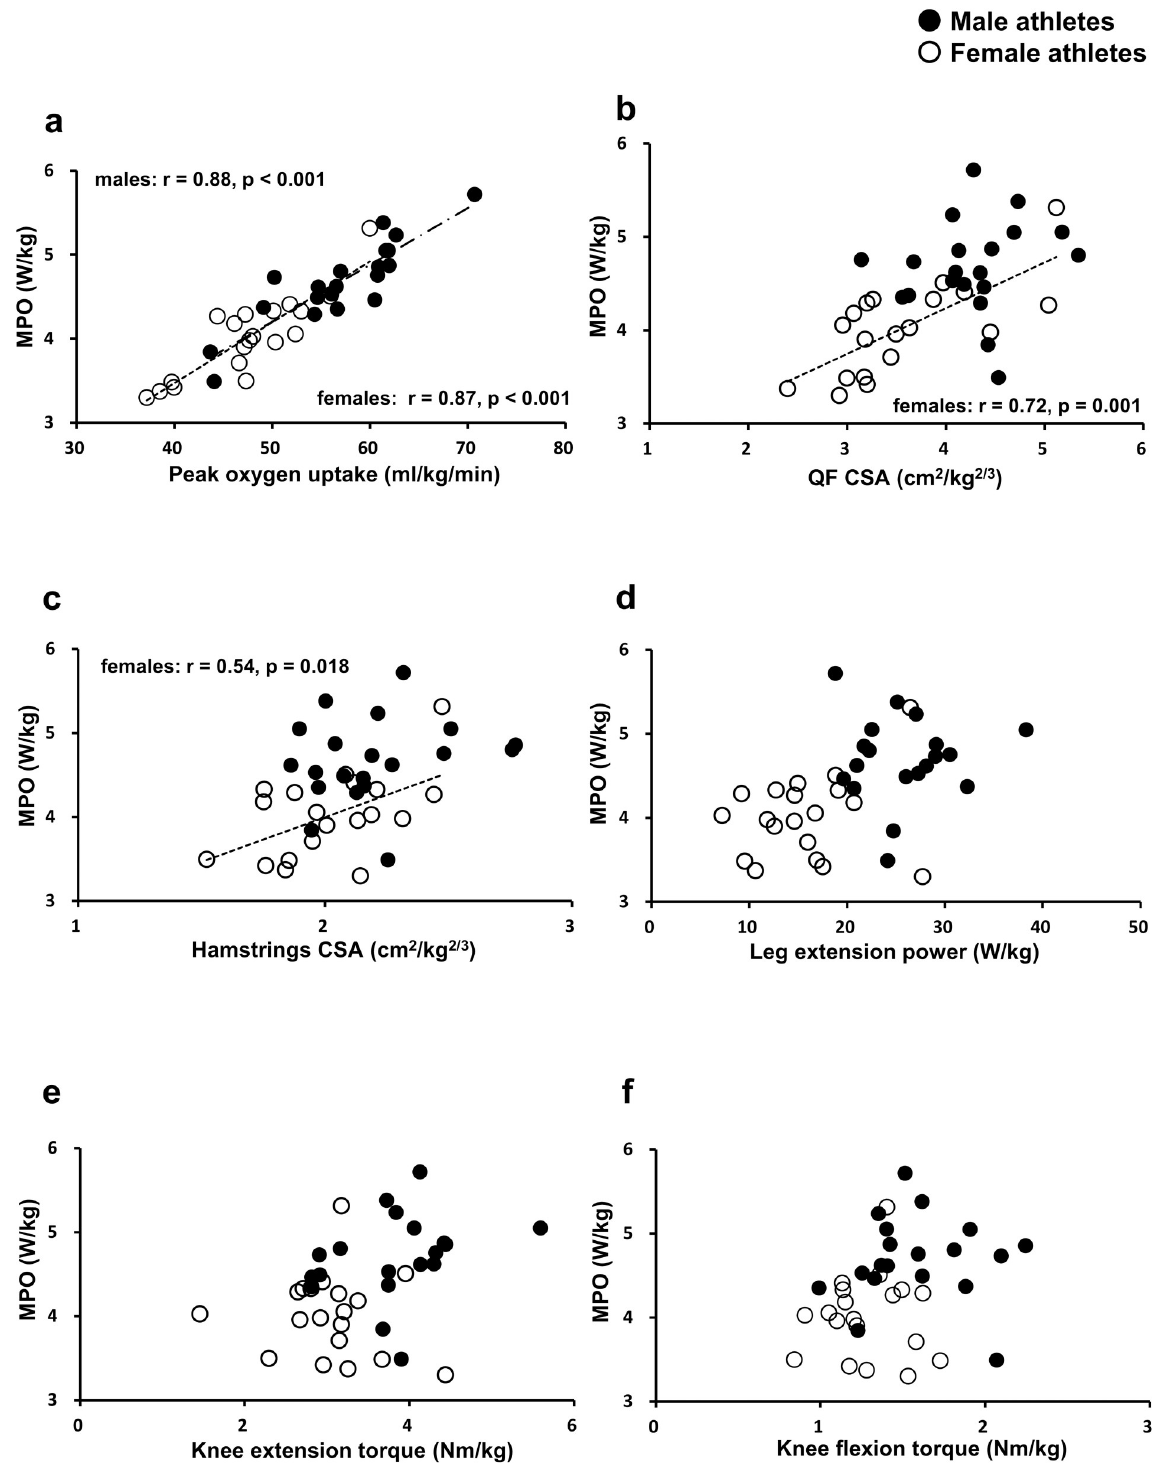
Fig 3. Correlations between maximal power output and (a) peak oxygen uptake, (b) QF CSA, (c) hamstrings CSA, (d) leg extension power, (e) knee extension torque and (f) knee flexion torque. MPO = maximal power output, QF = quadriceps femoris, CSA = cross-sectional area.